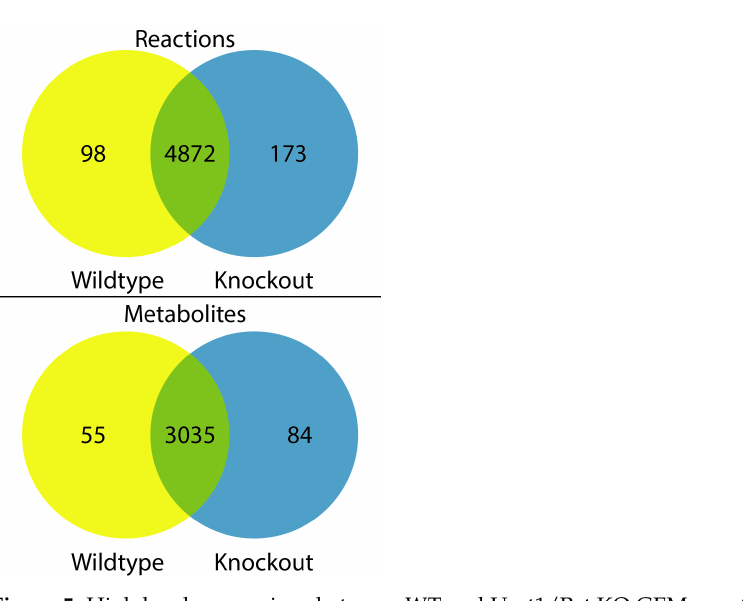
Figure 5. High level comparison between WT and Urat1/Rst KO GEMs. metabolic network content comparison highlighting the shared ( middle , green), unique wildtype ( left , yellow), and unique knockout ( right , blue) reactions ( top ) and metabolites ( bottom ). The large majority of reactions and metabolites are shared between the two models and there are approximately twice as many reactions that are unique to the KO (‘gain of function’) in comparison to